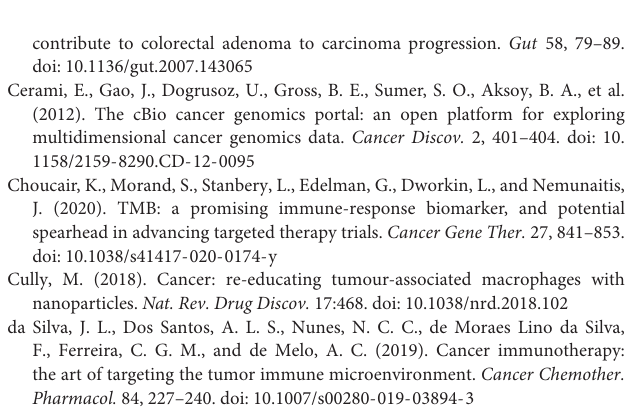
Supplementary Figure 1 | mRNA expression of MRGBP gene in normal human tissues and tumor cell lines. (A) Normal tissue expression. (B) mRNA expression in 38 kinds of tumor cell lines from the CCLE database. Supplementary Figure 2 | Kaplan-Meier survival curves comparing the high and low expression of MRGBP gene in various cancer types in Kaplan-Meier Plotter. Supplementary Figure 3 | Relationship between MRGBP expression and age in ESCA, KIRC, LGG, LIHC, LUAD, OV, SARC, STAD, and UCEC. Supplementary Figure 4 | Relationship between MRGBP expression and tumor stage in ACC, BRCA, COAD, ESCA, HNSC, KIRC, LIHC, LUSC, TGCT, and UVW. Supplementary Figure 5 | mRNA expression of MRGBP in different molecular subtypes of COAD, GBM, HNSC, KIRP, LGG, LUSC, OV, PCPG, PRAD, READ, SKCM, STAD ACC, BRCA, and UCEC. Supplementary Figure 6 | Pie chart showing the percentage of the different mutation types of MRGBP in various cancers according to the COSMIC database. Supplementary Figure 7 | Association between MRGBP expression and immune scores and stromal scores in multiple cancers. Supplementary Figure 8 | Correlation of MRGBP expression and infiltrating immune cells in multiple cancers. Supplementary Figure 9 | Functional state of MRGBP across 13 types of cancer. The red plots indicated that MRGBP was positively correlated and the blue plots indicated that MRGBP was negatively correlated with the functional state identified by CancerSEA. Supplementary Figure 10 | (A) Representative images of MRGBP immunohistochemistry in COAD and READ. (B) Association between MRGBP expression and prognosis in CGGA datasets. (C,D) Hazard ratio and P -value of constituents involved in univariate and multivariate Cox regression and some parameters of the MRGBP genes. Supplementary Figure 11 | (A) Immunohistochemical staining of MRGBP on LIHC tissue microarrays. (B) Expression of MRGBP in subgroups with different clinical parameters. Supplementary Table 1 | Database and its